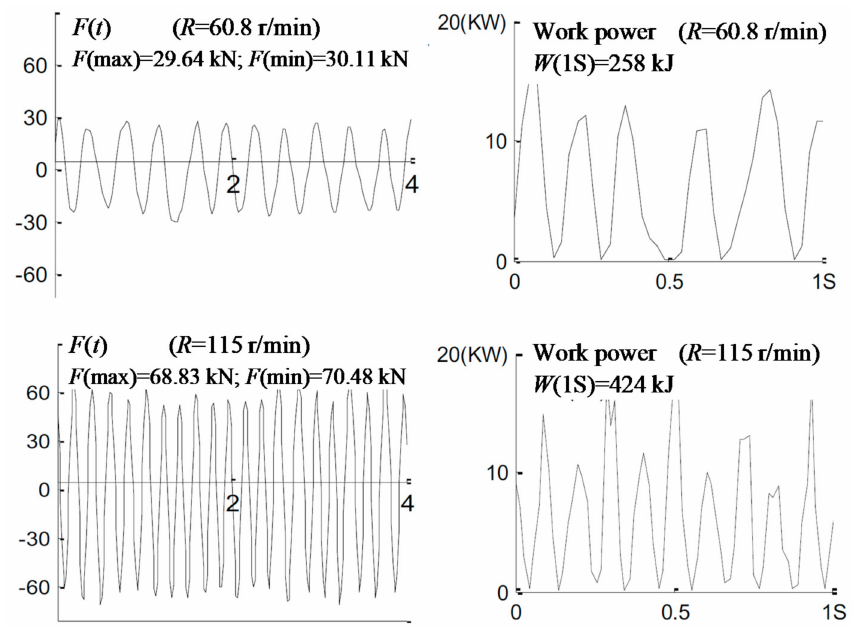
Figure 19. The time − domain diagrams of equivalent excitation force and its work power to the spring component under different rotation rate.